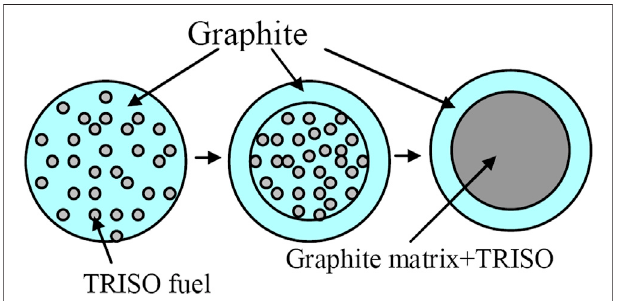
FIGURE 2 | Schematic diagram of the traditional RPT method.